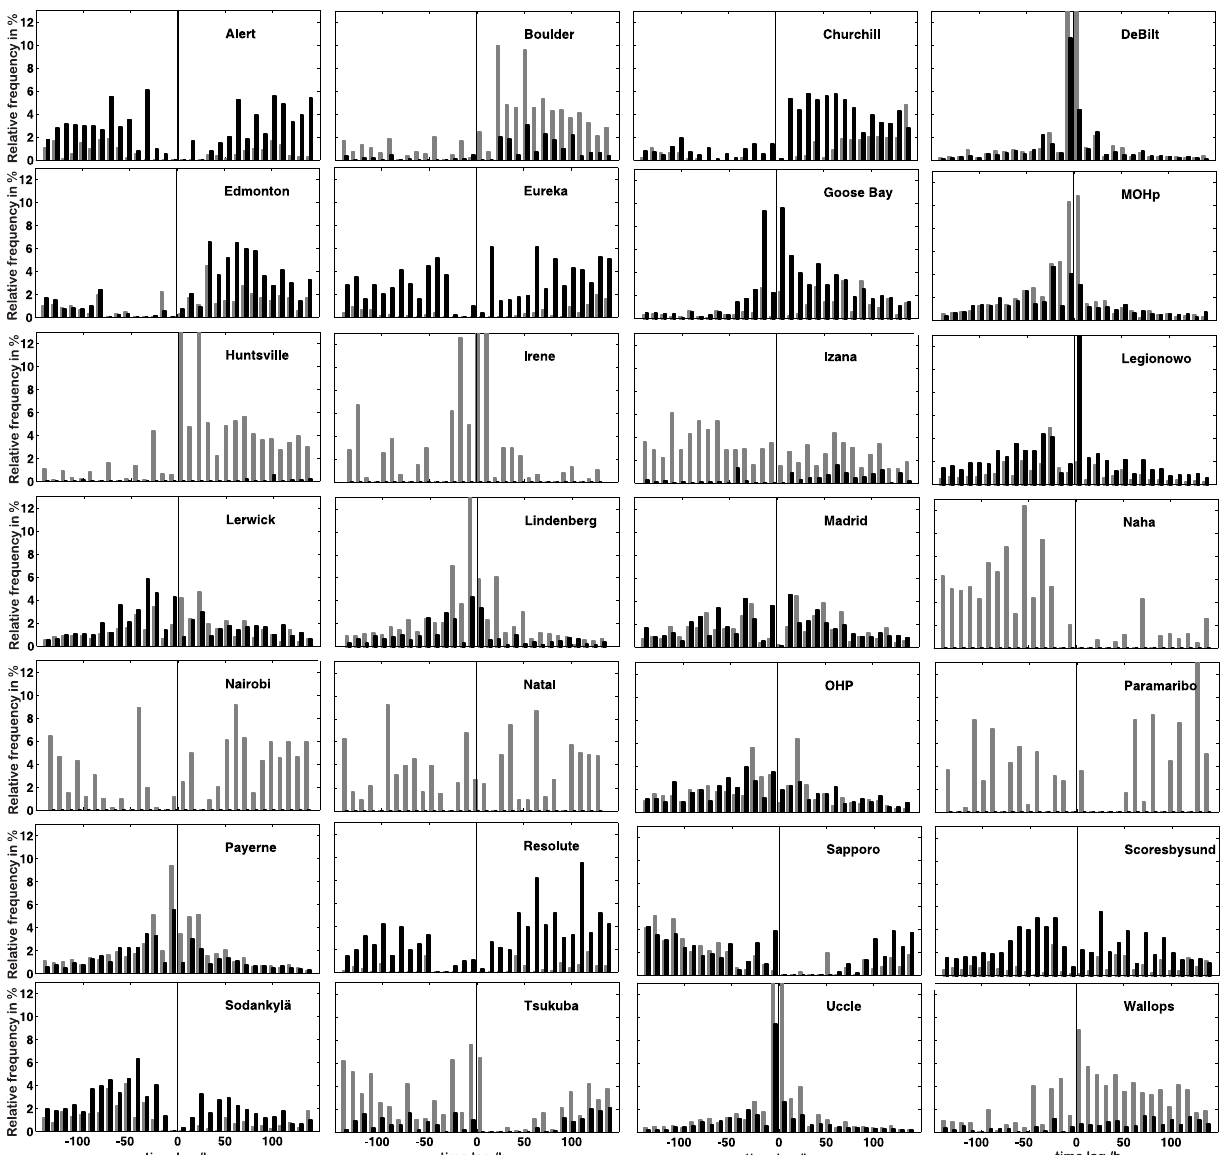
Fig. 2. Temporal distribution of the number of matches at different stations. The time lag is positive for forward-only trajectories and negative for backward-only trajectories. Matches in the stratosphere are shown in black, while matches in troposphere are shown in gray. The bin size is 10 h.